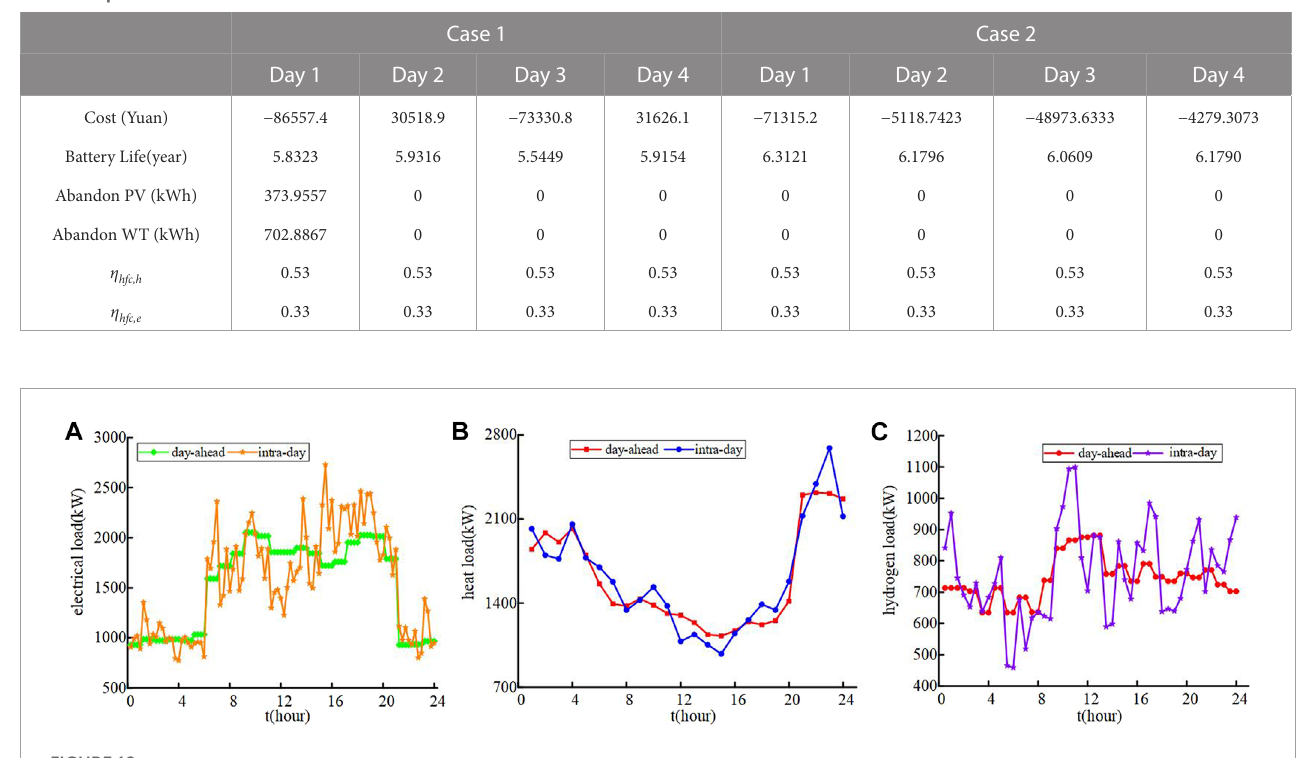
FIGURE 12 Intra-day forecast data. (A) Electricity load. (B) Heat load. (C) Hydrogen load.